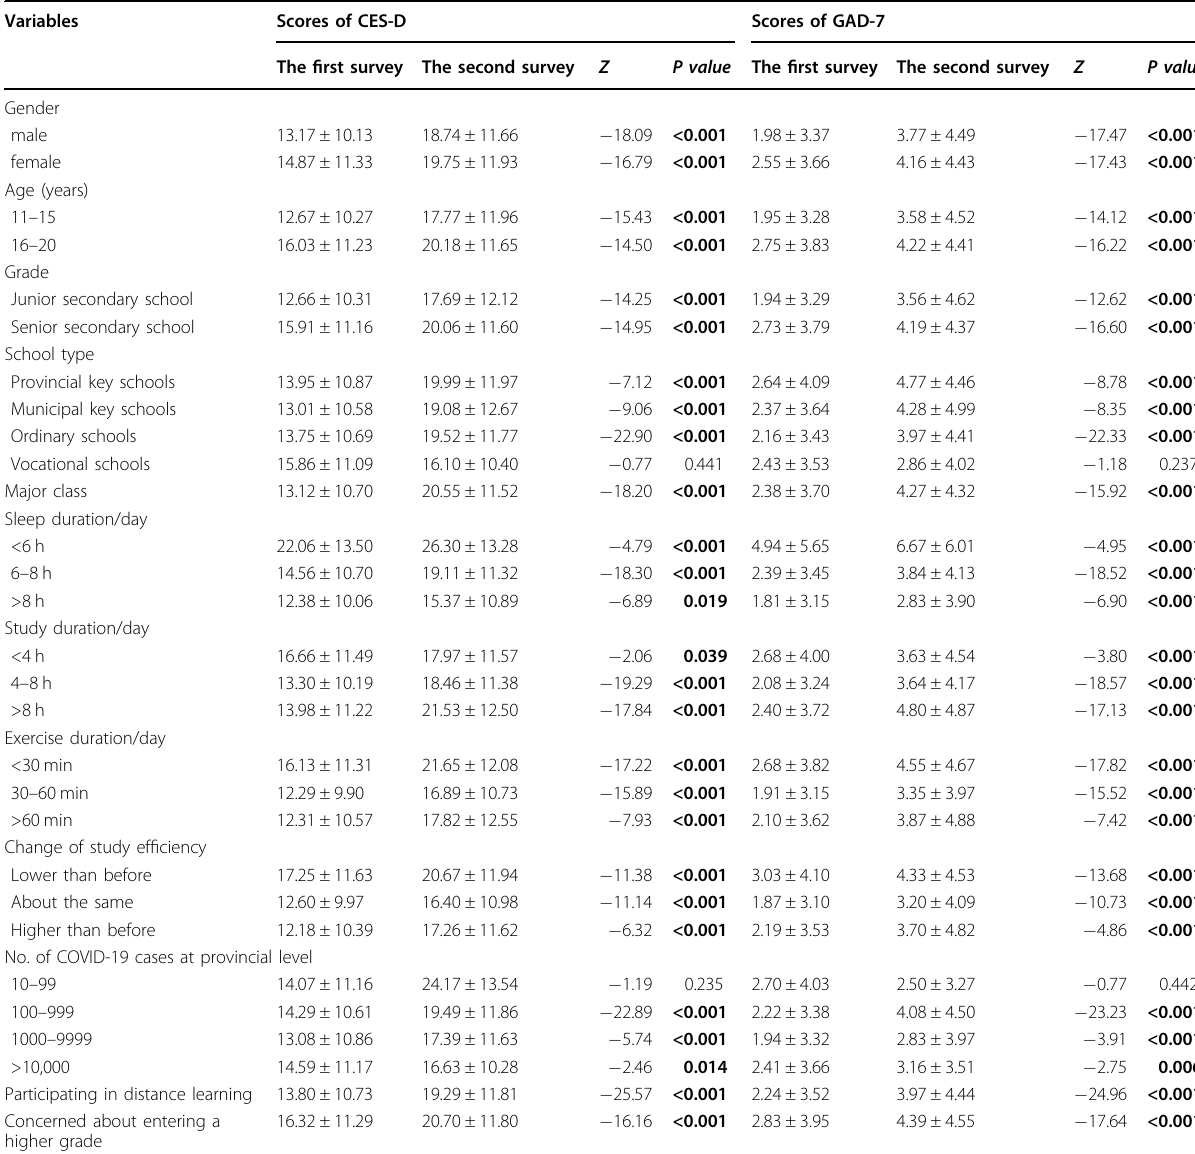
Table 1 The comparison of CES-D and GAD-7 scores between the fi rst ( n = 9554) and second ( n = 3886) surveys. Variables Scores of CES-D Scores of